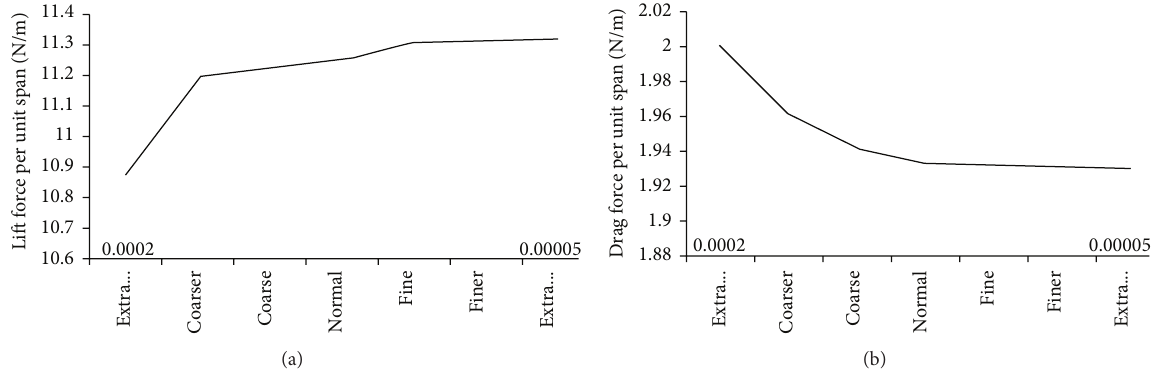
Figure 4: Grid sensitivity study for clean S809 airfoil at zero degree angle of attack; (a) lift force per unit span; (b) drag force per unit span.